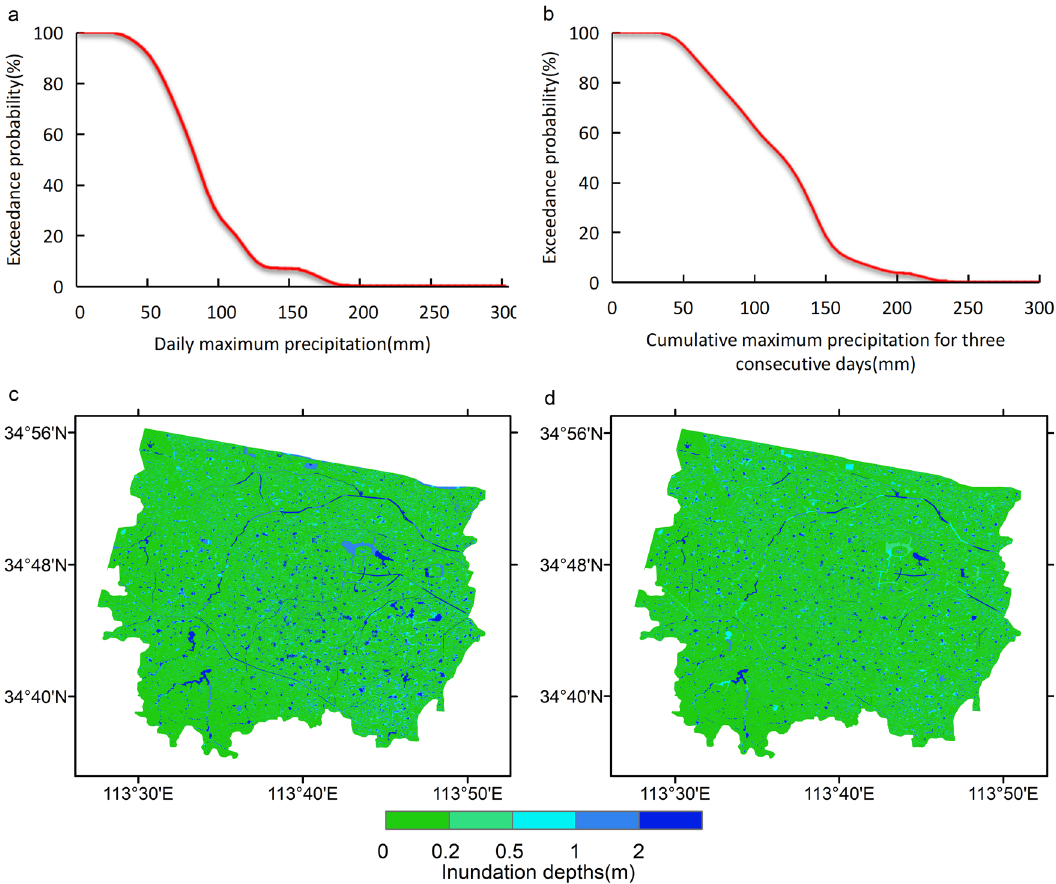
Fig. 4 Simulation results for the Zhengzhou rainstorm. a , b The exceedance probability curves of precipitation. a Daily maximum precipitation. b Cumulative maximum precipitation for three consecutive days. The horizontal axis is precipitation value, and the vertical axis is exceedance probability, i.e., the probability of precipitation being greater than or equal to a given value. c , d The inundation depth distribution in Zhengzhou. c Inundation depth of actual precipitation. d Inundation depth of 100-year return period